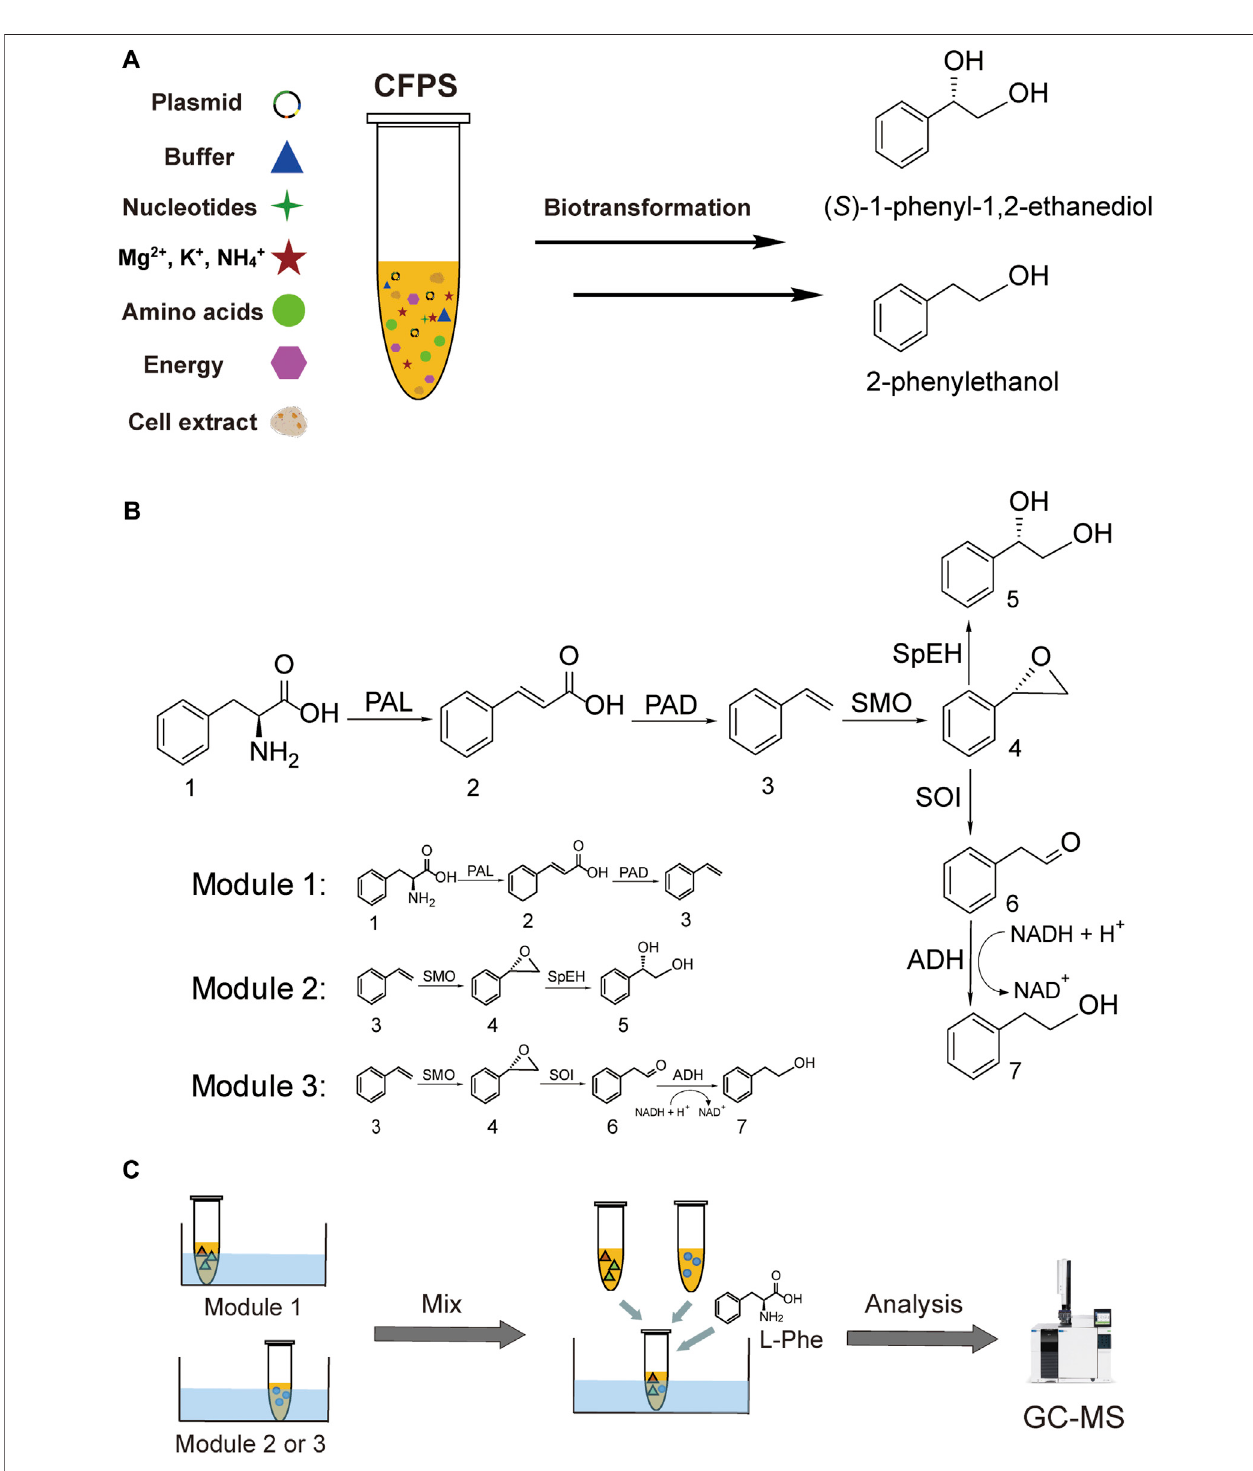
FIGURE 1 | Cell-free synthesis of ( S )-PED and 2-PE. (A) CFPS reaction and the synthesis of target chemicals. (B) Overall enzymatic pathways and designing of three modules. (C) Modular cell-free systems for the product formation. Abbreviations: CFPS, cell-free protein synthesis; PAL, phenylalanine ammonia lyase; PAD, phenylacrylic acid decarboxylase; SMO, styrene monooxygenase; SpEH, epoxide hydrolase; SOI, styrene oxide isomerase (also called StyC); ADH, alcohol dehydrogenase. Chemicals 1 – 7: 1, L -phenylalanine (L-Phe); 2, cinnamic acid; 3, styrene; 4, styrene oxide; 5 ( S )-1-phenyl-1,2-ethanediol (( S )-PED); 6, phenylacetaldehyde; 7, 2-phenylethanol (2-PE).